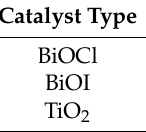
Table 2. Properties of Various Catalysts. Reused with permission from reference [12]. Copyright Elsevier 2015.